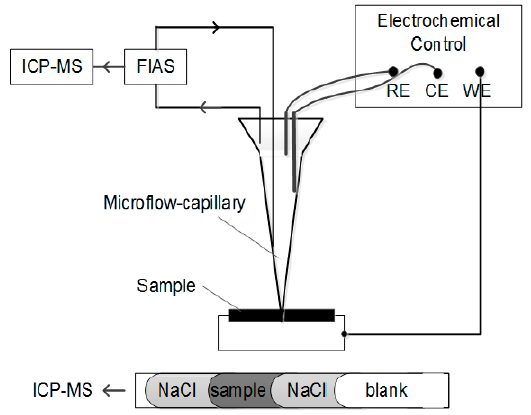
Figure 12. Experiment layout of the µFC-FIAS-ICPMS coupled with three-electrode electro-chemical control unit [42].